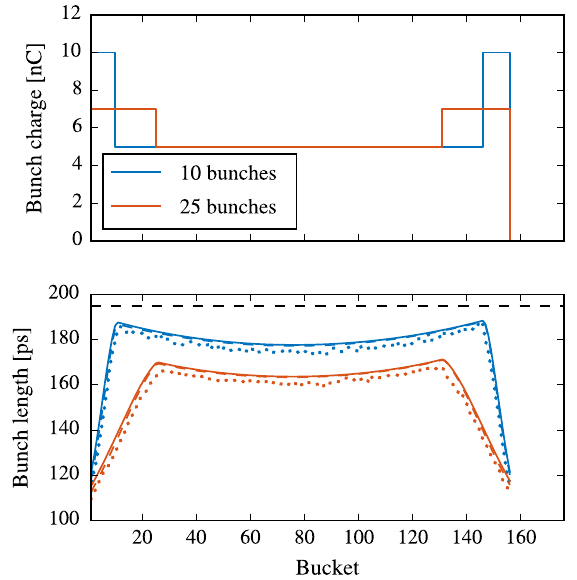
FIG. 12. Bunch length for a fill with 156 bunches for two different charge distributions (10 bunches on both sides of the gap with 2 times nominal charge and 25 bunches on both sides of the gap with 1.4 times nominal charge) for the matrix formulation (solid), F ILL P ATTERN S IM (dashed), and MBTRACK (dotted). The analytical value for a uniform fill pattern (black dashed) is shown for